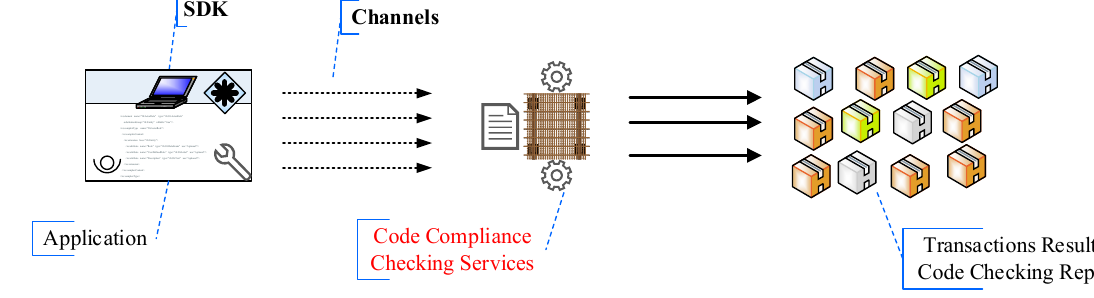
Figure 11. Constructing blocks of the results.